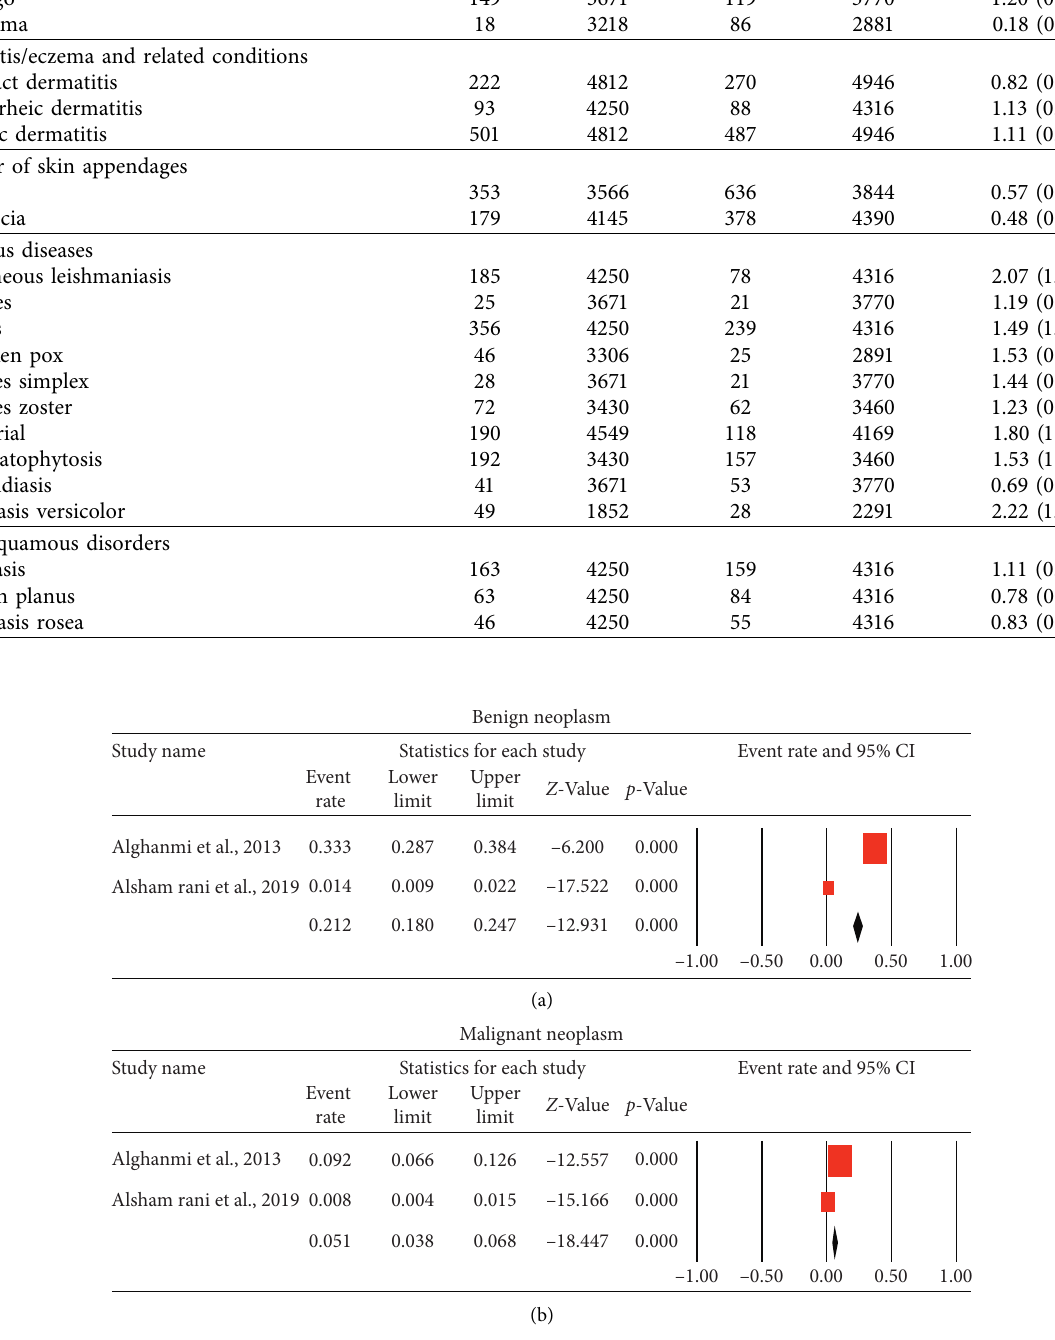
Figure 3: Forest plot of the pooled proportion for the prevalence of skin cancer: (a) benign neoplasm and (b) malignant